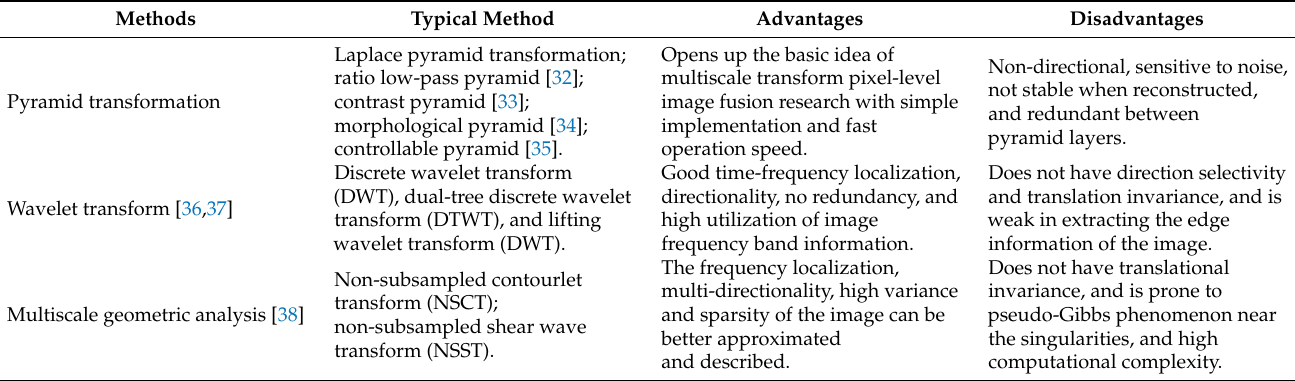
Table 1. Advantages and disadvantages of multiscale decomposition